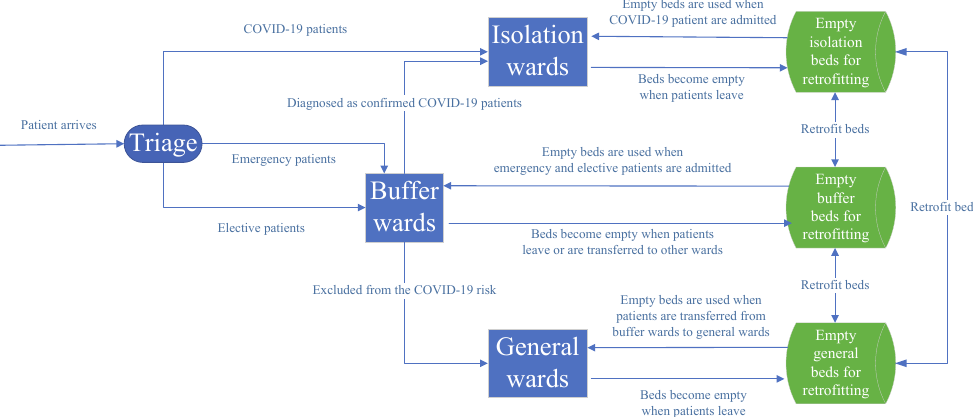
Figure 1. The illustration of patient flow and bed allocation considering buffer